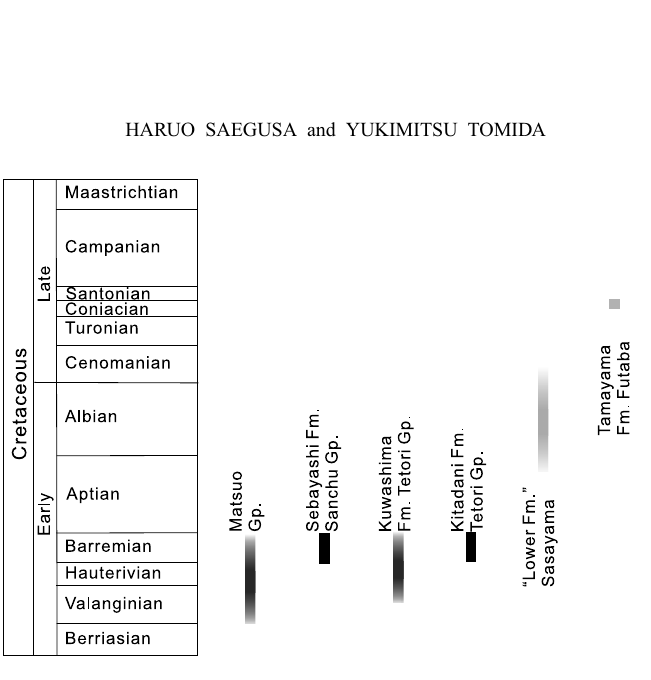
Fig. 3 – Geologic age of the sauropod bearing formations in Japan. The formations indicated by black bars (left four bars) provided the sauropod teeth, with the SI value less than 3, while those indicated by gray bars (right two bars) provided those with the SI value over